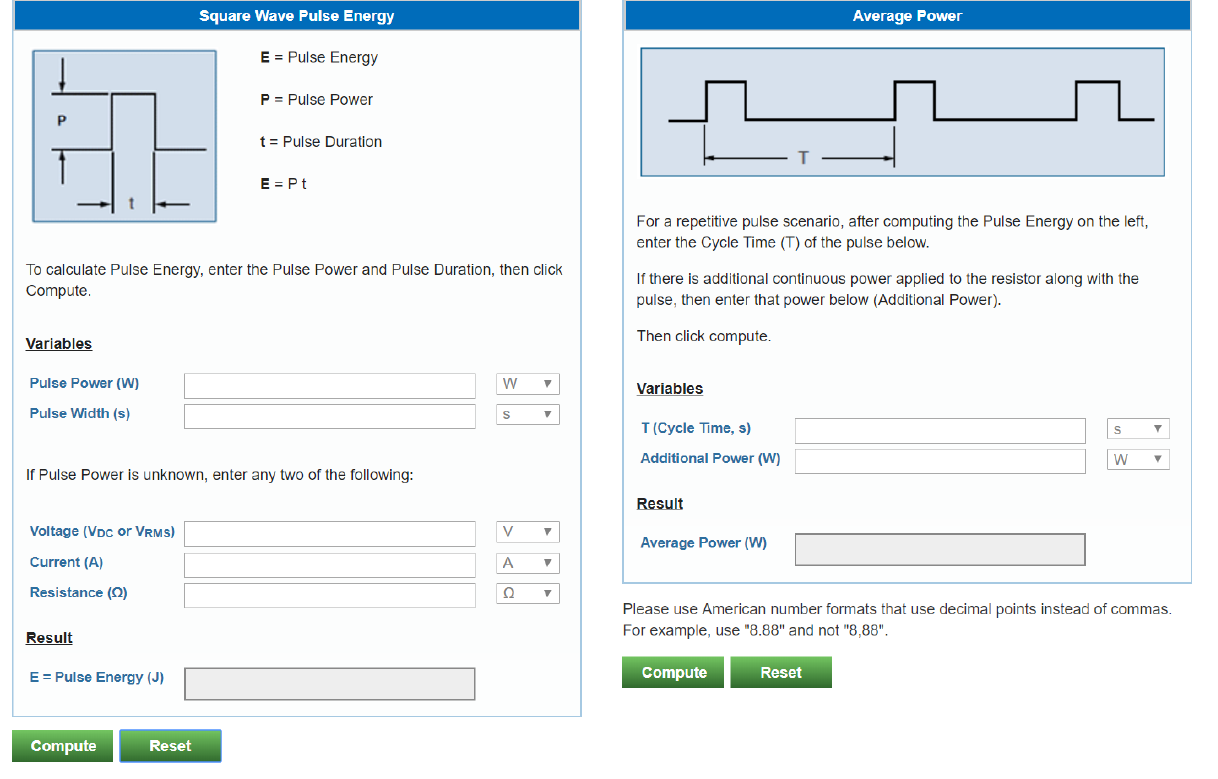
Figure 9. Powercast online calculator.